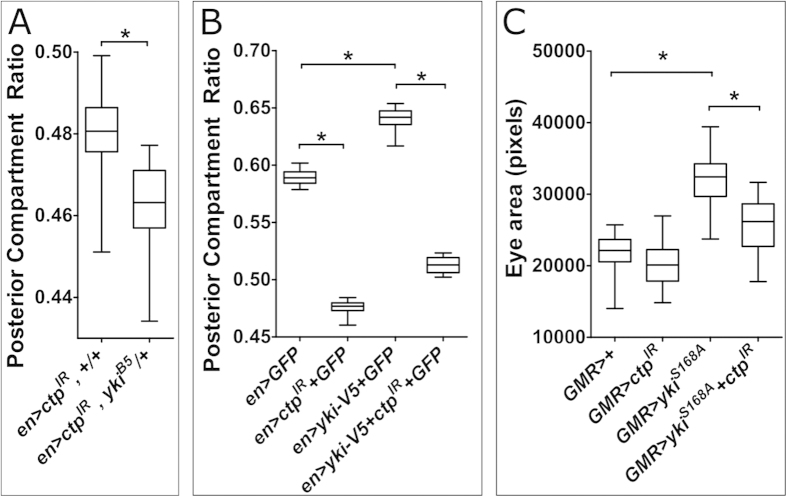
Genetic interactions between ctp and yki in control of wing and eye size.Box-plot representation of the effect of (A) the ykiB5 allele (n = 13), *p < 0.0001 or (B) a UAS-yki-V5 transgene (n = 22, with GFP n = 12, with ctpIR + GFP), on PCR in control (en > GFP, n = 12) or Ctp-depleted (en > ctpIR + GFP, n = 18) adult wings. All *p values < 0.0001. (C) Box-plot showing the effect of GMR-Gal4 driven Ctp-depletion at 29 °C among eye cells on final adult eye area (2-dimensional en face circumference) and the ability of the ctpIR transgene to suppress this metric in the background of the GMR-ykiS168A hyperactive allele. SEMs are indicated; (GMR, n = 24; GMR > ctpIR, n = 22; GMR > ykiS168A, n = 41; GMR > ykiS168A + ctpIR, n = 24), both *p values < 0.0001.